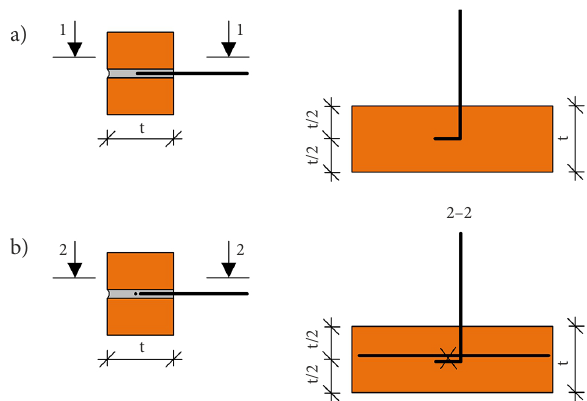
Figure 3. Solutions of flexible tie instalation into the mortar bed joint: a – 1 method, b – 2 method